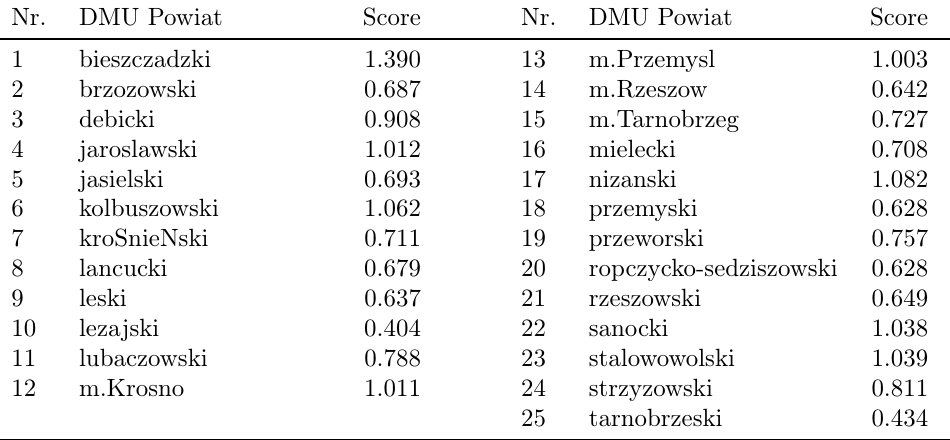
Table 5: SBM-SE scores of 25 NUTS-4 Powiats of Podkarpackie in Poland